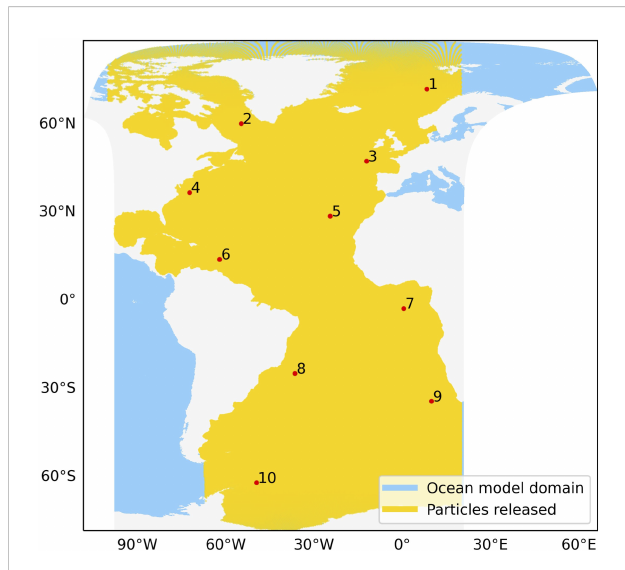
FIGURE 1 GLOB16 Ocean model data domain (in blue ) and released particles (in yellow ) along with locations of sample stations in the Atlantic Ocean ( red